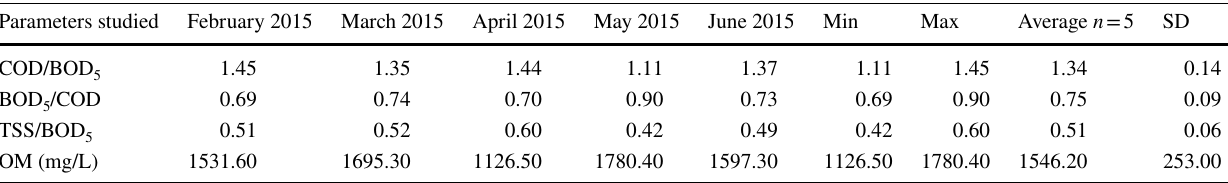
Table 3 Oxidizable matter and biodegradability of Mzar sewage effluent Parameters